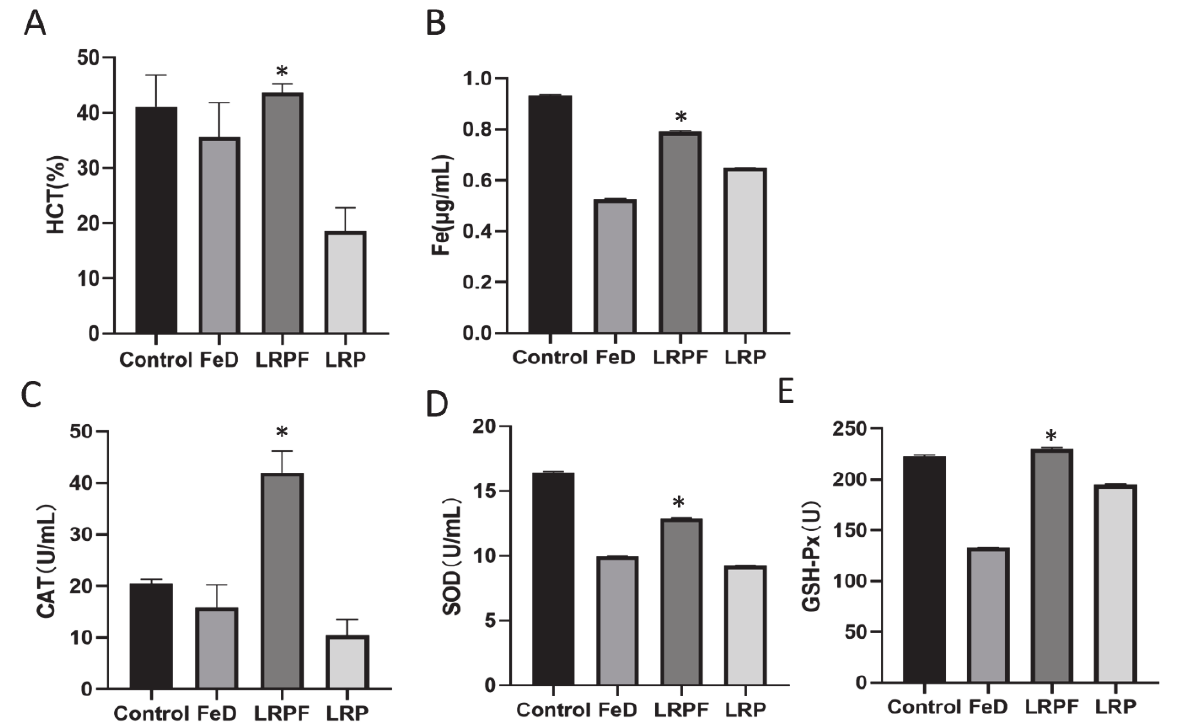
Figure 4. Effects of LRPF on blood parameters and antioxidant indexes in the model mouse of iron deficiency anemia. The level of HCT, Fe, CAT, MDA, SOD and GSH-PH in serum. ( A ) HCT. ( B ) Fe. ( C ) CAT. ( D ) SOD. ( E ) GSH ‐ Px. (* p < 0.05).